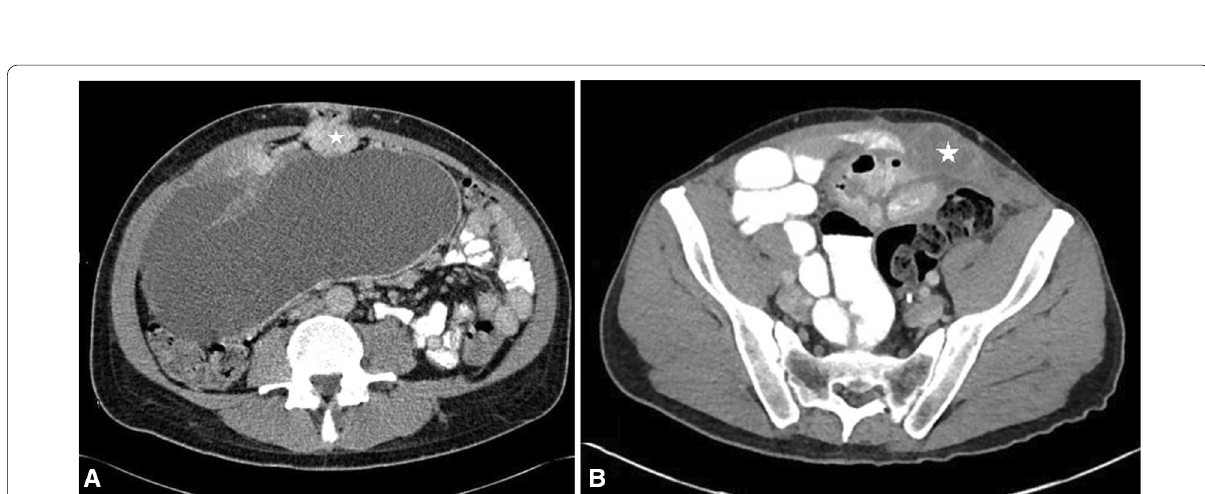
Fig. 12 a , b : Abdominal wall disease in two different patients with malignant peritoneal mesothelioma. a CT of a patient with sarcomatoid type of peritoneal mesothelioma showing enhancing soft tissue nodule (*) in the abdominal wall. b CT of a patient with epithelioid mesothelioma shows a large lateral abdominal wall mass (*) abutting and tethering small bowel